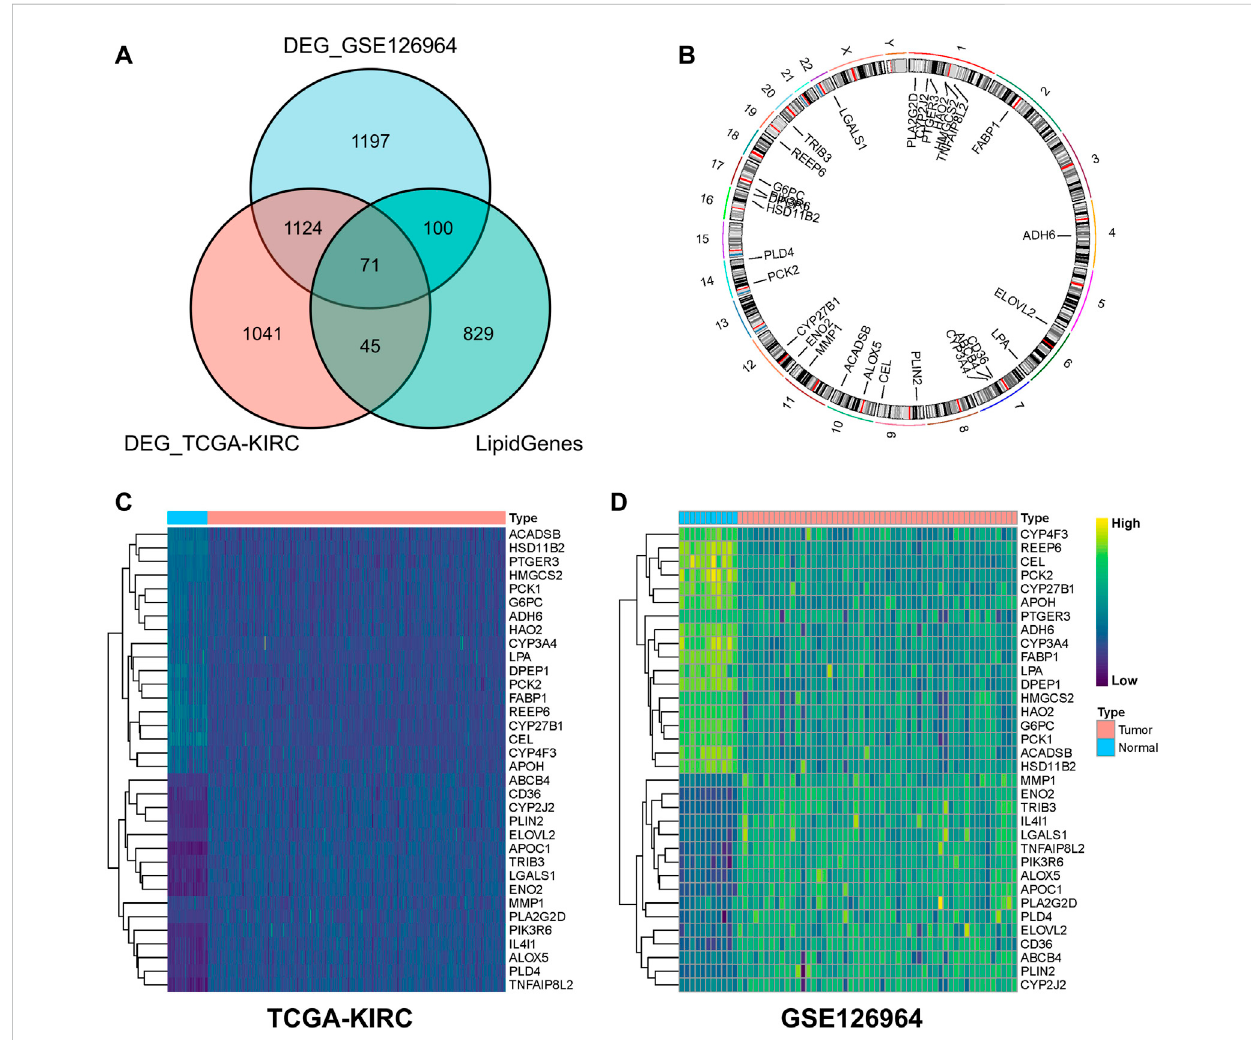
FIGURE 2 Screening for differential lipid metabolism genes (LMGs). (A) Venn diagram of common differential LMGs between GSE126964 and TCGA-KIRC datasets. (B) Chromosomal locations of LMGs. Heatmap illustrating LMG expression differences between clear cell renal cell carcinoma (ccRCC) and normal tissues in (C) TCGA-KIRC and (D) GSE126964